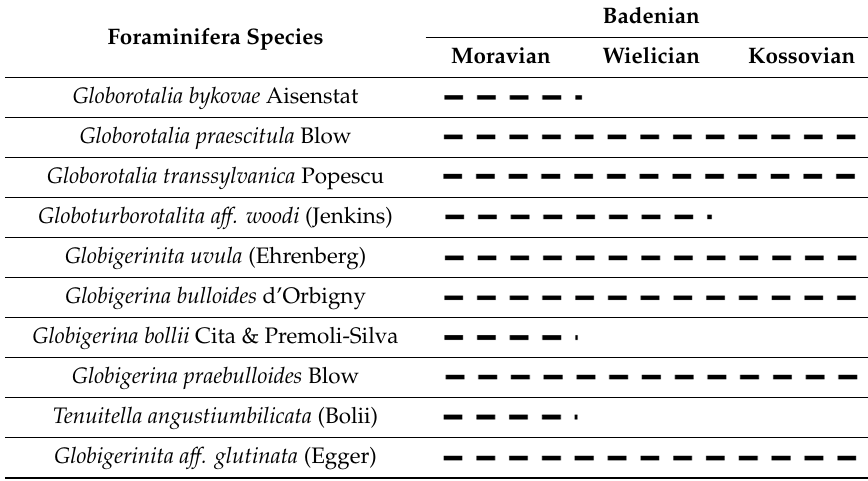
Table 1. Stratigraphic range of the foraminifera species identified in the gypsum samples, ranges based on